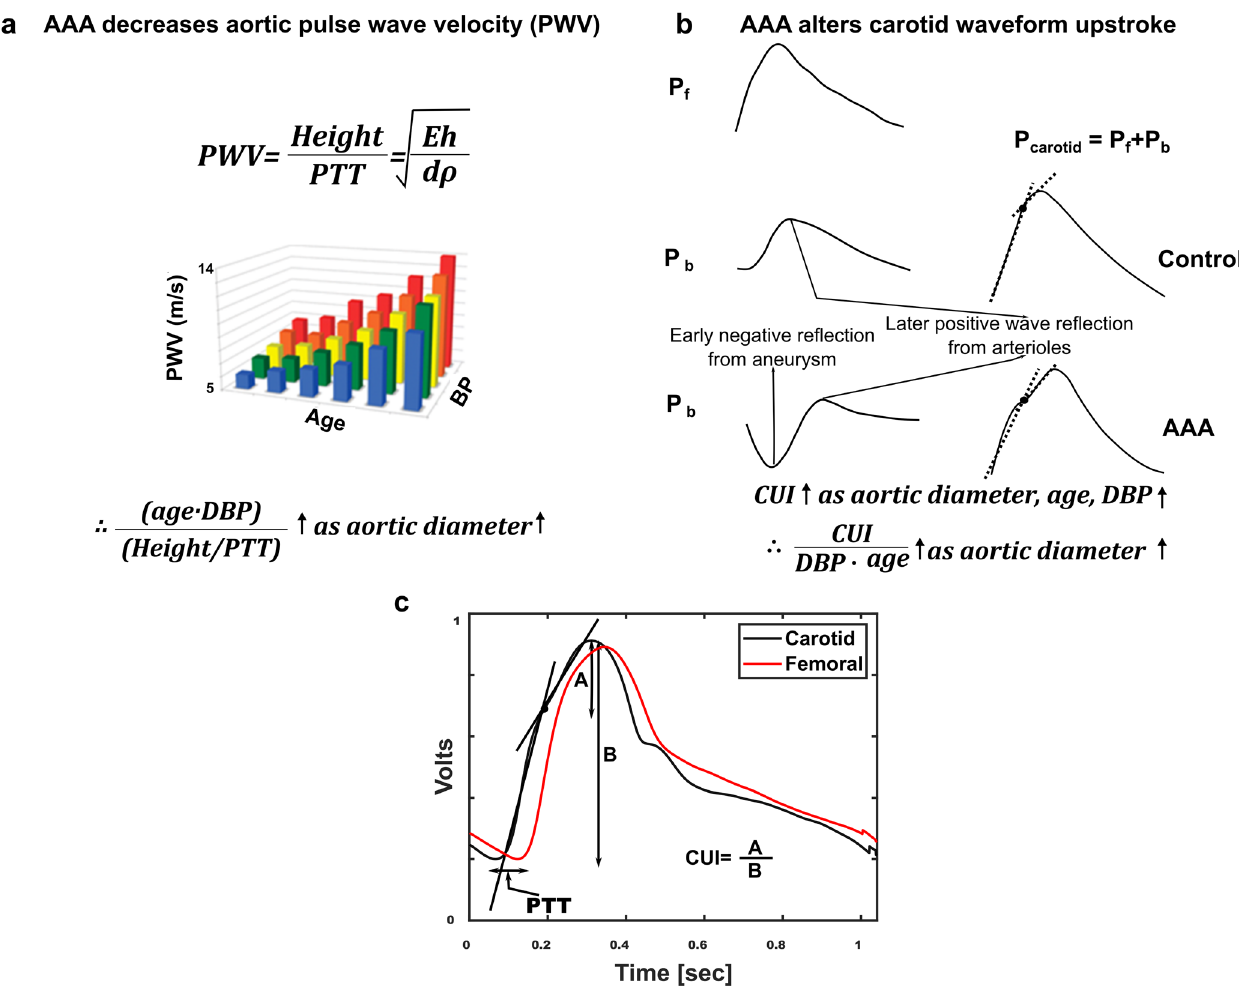
Fig. 2 Candidate arterial waveform features based on physiology for indicating the aortic diameter. a Pulse transit time (PTT ≈ height/ PWV) normalized for age and diastolic BP (DBP) should increase with aortic diameter. b A carotid upstroke index (CUI) similarly normalized should increase with AAA diameter due to the early, negative wave re fl ection. P carotid is the carotid BP waveform; P f and P b , forward and backward traveling pressure waves. The waveforms and waves are cartoons. c PTT is detected as the foot-to-foot time delay between the carotid and femoral artery waveforms, while CUI is detected from the carotid artery waveform via fi tting two lines to its upstroke. The waveforms are ensemble averaged waveform beats of a